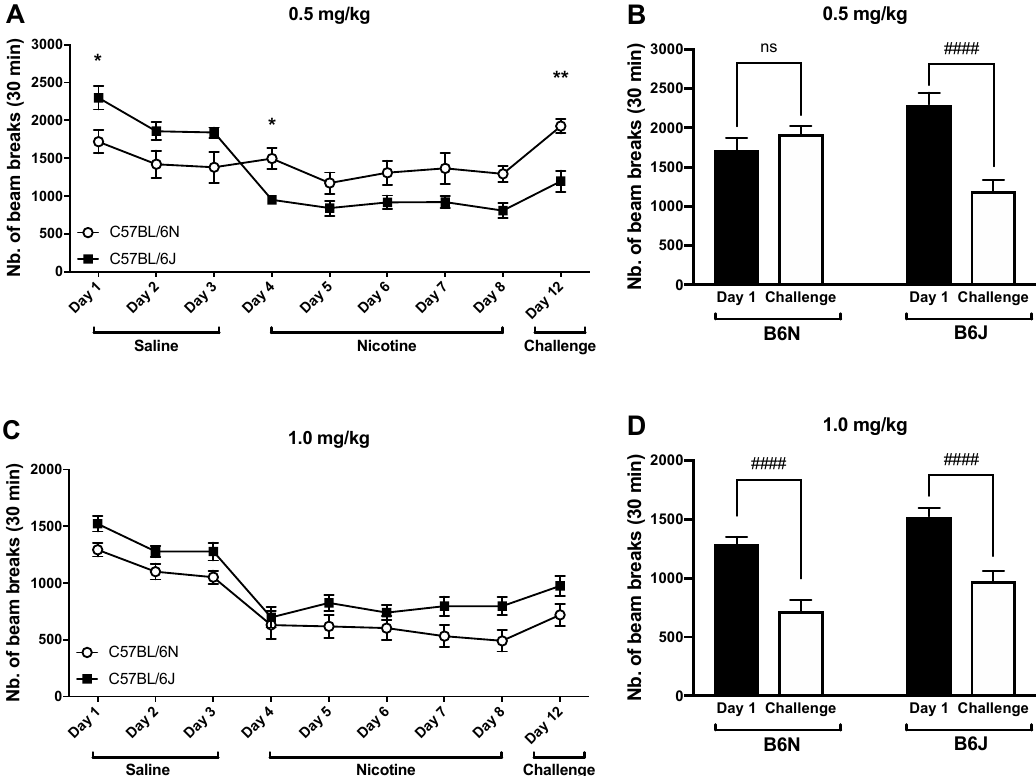
Figure 3. Locomotor sensitization to repeated nicotine administration in male B6J and B6N substrains. Mice were injected s.c. with 0.9% saline for 3 days, nicotine (0.5 or 1.0 mg / kg) for 5 days, and after a washout period (day 6 to day 8), mice were challenged with the same dose of nicotine. Each day, five minutes post subcutaneous administration of the vehicle (0.9% saline) or nicotine, their locomotor activity was measured for 30 min. ( A , B ) Locomotor response to 0.5 mg / kg nicotine, and ( C , D ) locomotor response to 1.0 mg / kg nicotine. Each data point is representative of the averaged mouse response at the given time-point 30 min post injection. The data are expressed as the number of photocell interruptions and reported as the mean ± SE of 12–15 mice. * p < 0.05, ** p < 0.01 from Holm-Sidak post hoc test following a multiple t-test analysis between both substrains at various time points, or #### p < 0.0001 from the Holm–Sidak post hoc test following a two-way RM repeated measure ANOVA, comparing the averaged mouse response at day 1 and day 12 (challenge day).